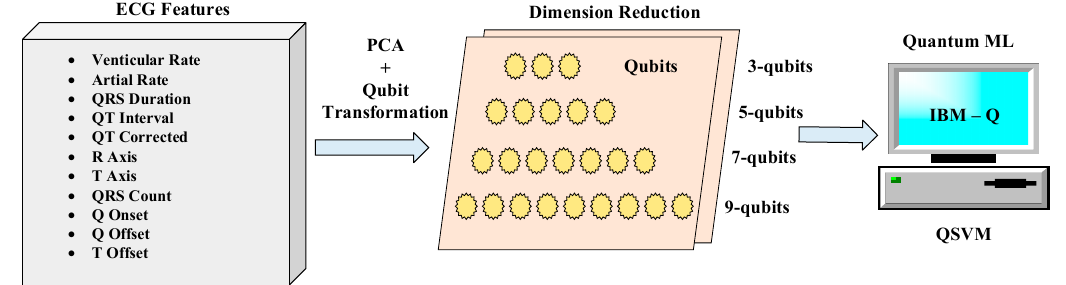
Figure 2. A block representation of our proposed method.